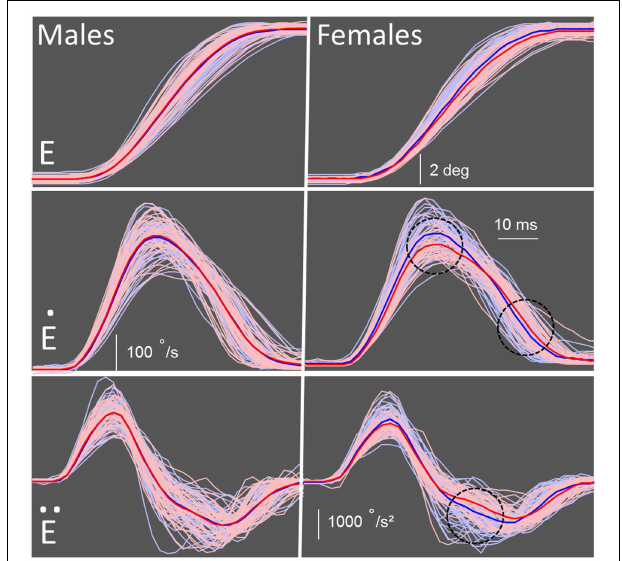
FIGURE 3 | Schematic of metric measures. Individual data for each participant are shown in pink for the participants with FASD ( n = 71 ) and light blue for the controls ( n = 113 ). The mean of the FASD group is shown as a bold red line and control group as a bold blue line. Males (control vs. FASD) are on the left and females (control vs. FASD) are on the right. (E) Eye traces of correct saccades when participants look from a central fixation point to a peripheral target. ( ˙ E) Velocity profiles of the control and FASD participants. Peak velocity was significantly slower in the females with FASD compared to control females. (Ë) Acceleration and deceleration profiles of all participants. Peak deceleration, but not acceleration, was significantly slower in the females with FASD compared to control females. ∗ Significant results ( p < 0 . 05 ) are indicated by black dotted circle.